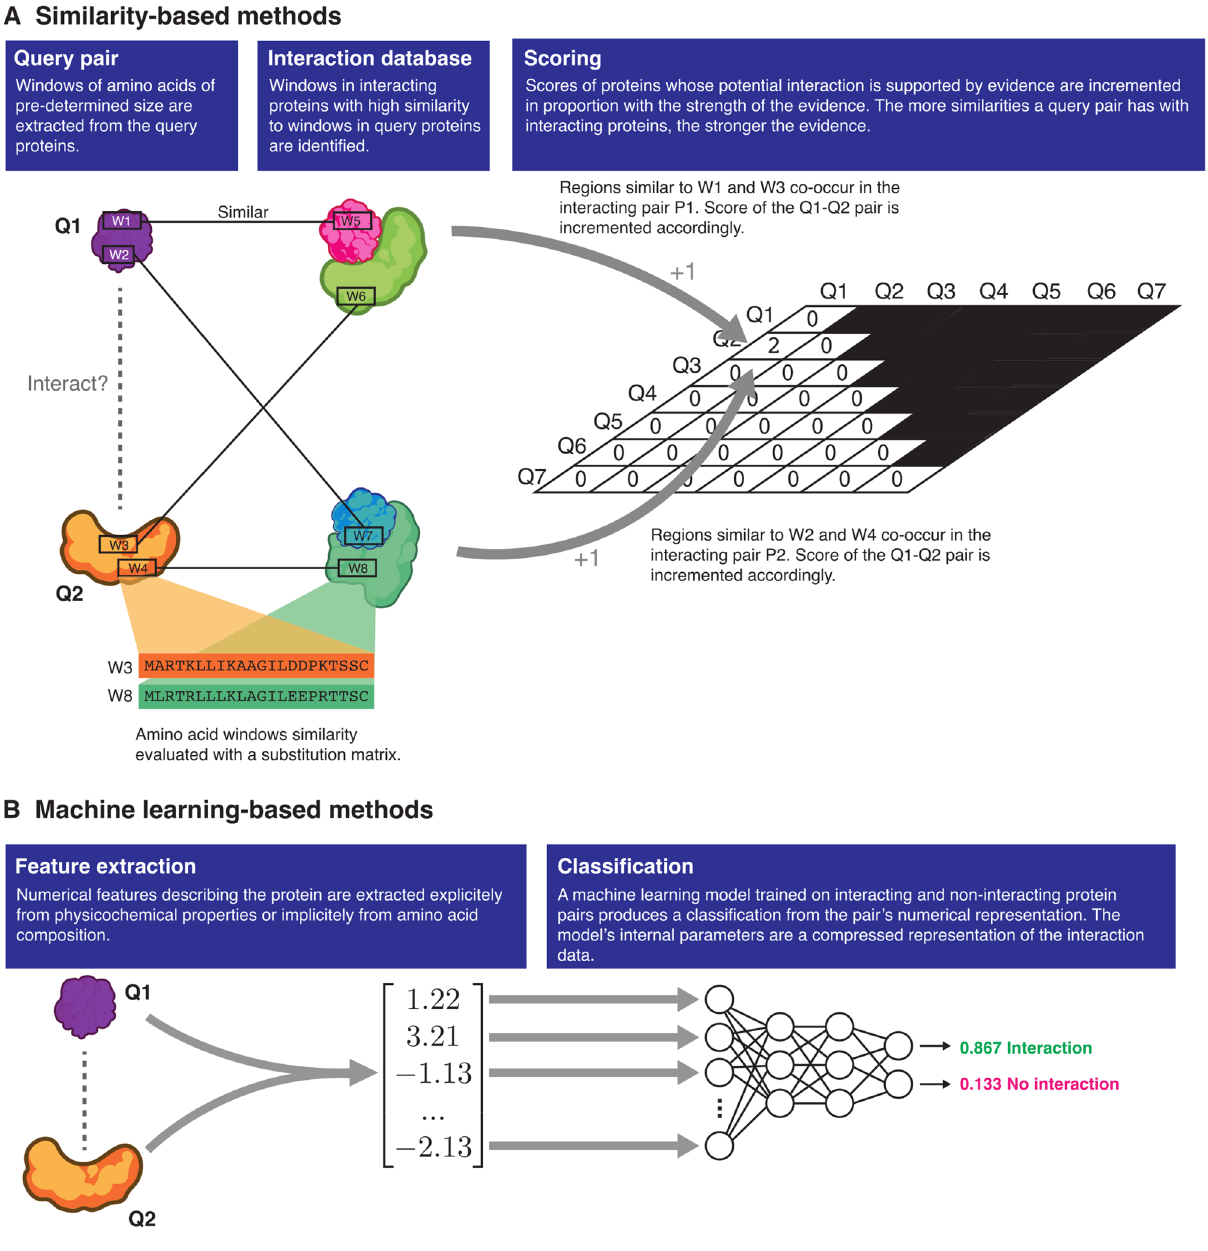
Figure 1. Similarity- and machine learning-based protein–protein interaction predictors. Similarity-based methods differ from machine learning-based methods in that the evidence supporting an interaction is quantified by counting the number of similarities to known instances of interacting proteins in a database. Machine learning-based methods are trained to learn patterns found in interacting protein pairs, and identify those patterns in the query